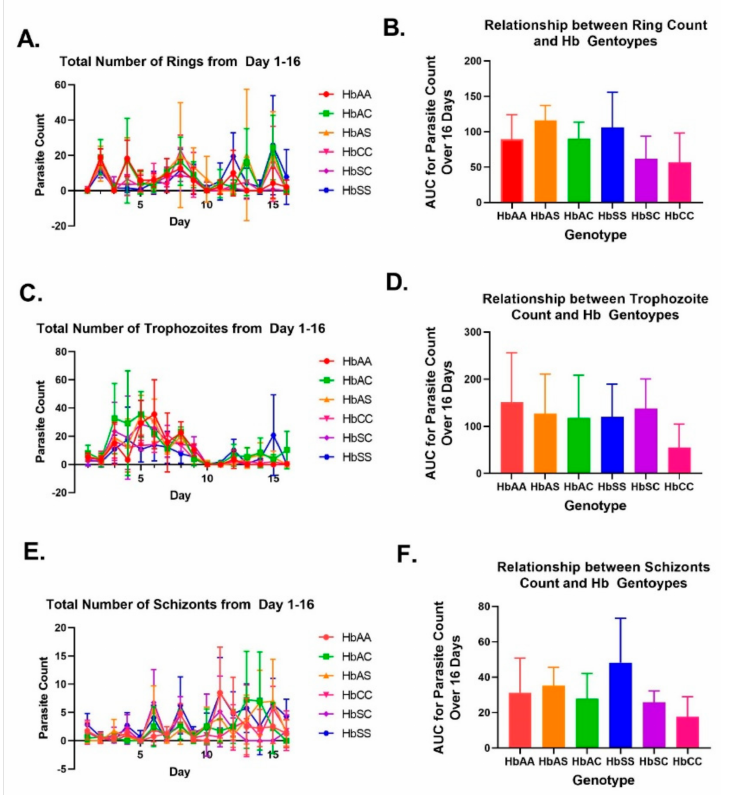
Figure 2. Ring, trophozoite, and schizont count for each sickle Hb genotype over 16 days. Red is for HbAA, orange for HbAS, green for HbAC, blue for HbSS, purple for HbSC, and pink for HbCC. Area under the curve (AUC) was used to estimate parasite counts over 16 days. A one-way ANOVA and a Tukey’s multiple comparison test were used. ( A ) Ring counts for each sickle Hb genotype. ( B ) AUC of overall ring count for each genotype. ( C ) Trophozoite counts for each sickle Hb genotype. ( D ) AUC for overall trophozoite count for each sickle Hb genotype. ( E ) Schizont counts for each sickle Hb genotype. ( F ) AUC for overall schizont count for each